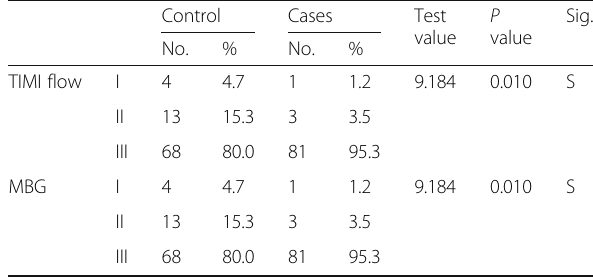
Table 4 Comparison between cases and controls regarding angiographic TIMI flow score and myocardial blush grade Control Cases Test value